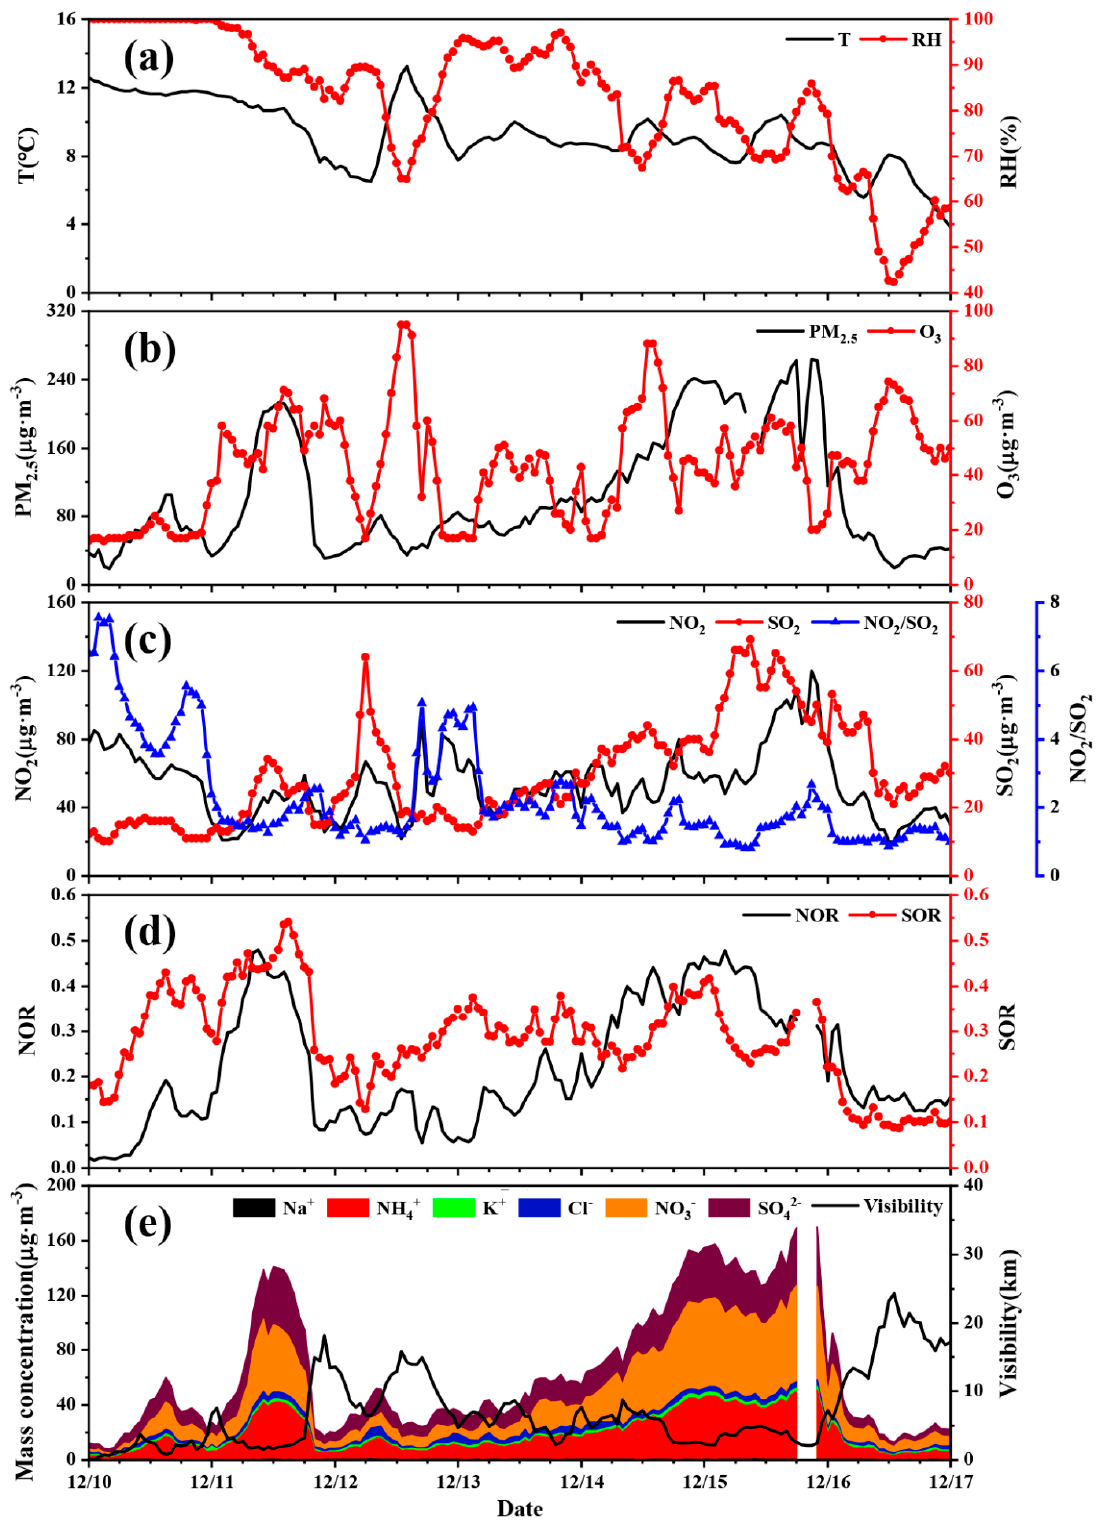
Figure 7. Time series of ( a ) temperature (T) and RH, ( b ) PM 2.5 and O 3 , ( c ) NO 2 , SO 2 and NO 2 /SO 2 ratio, ( d ) NOR and SOR, ( e ) ions and visibility at sampling siten during 10–16 December 2015. A clear increase of nitrates could be observed in Figure 7, and nitrate dominated WSIIs in the studied period, which indicated that nitrate had become the major constitutes of PM 2.5 during haze pollution. In terms of PM 2.5 concentrations, this polluted episode can be divided into four groups: Clean, transition and polluted, heavily polluted periods. Generally, the ratio of NO 3 − /SO 42 − is be